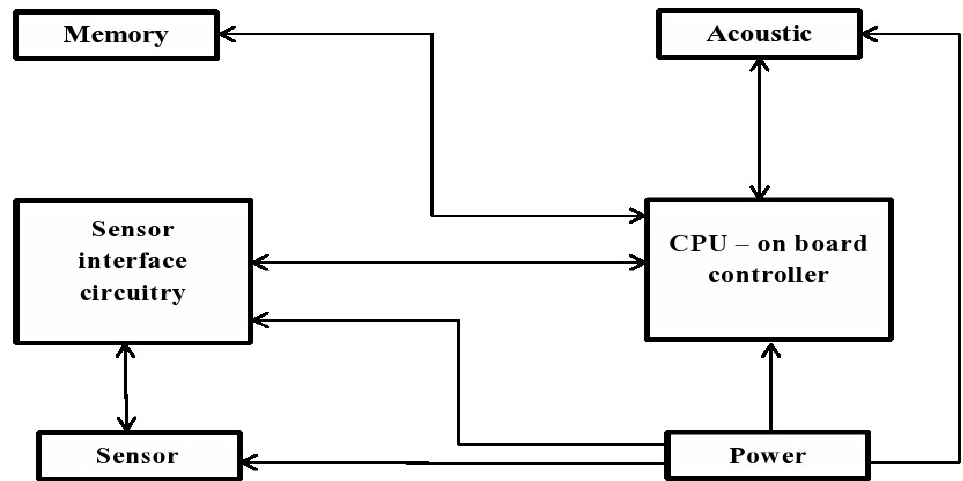
Figure 3. Submerged sensor’s internal structure.